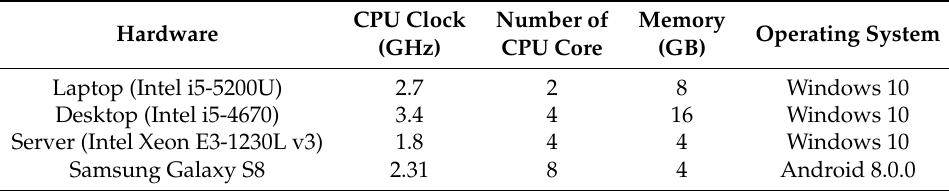
Table 2. Details of hardware environments for performance